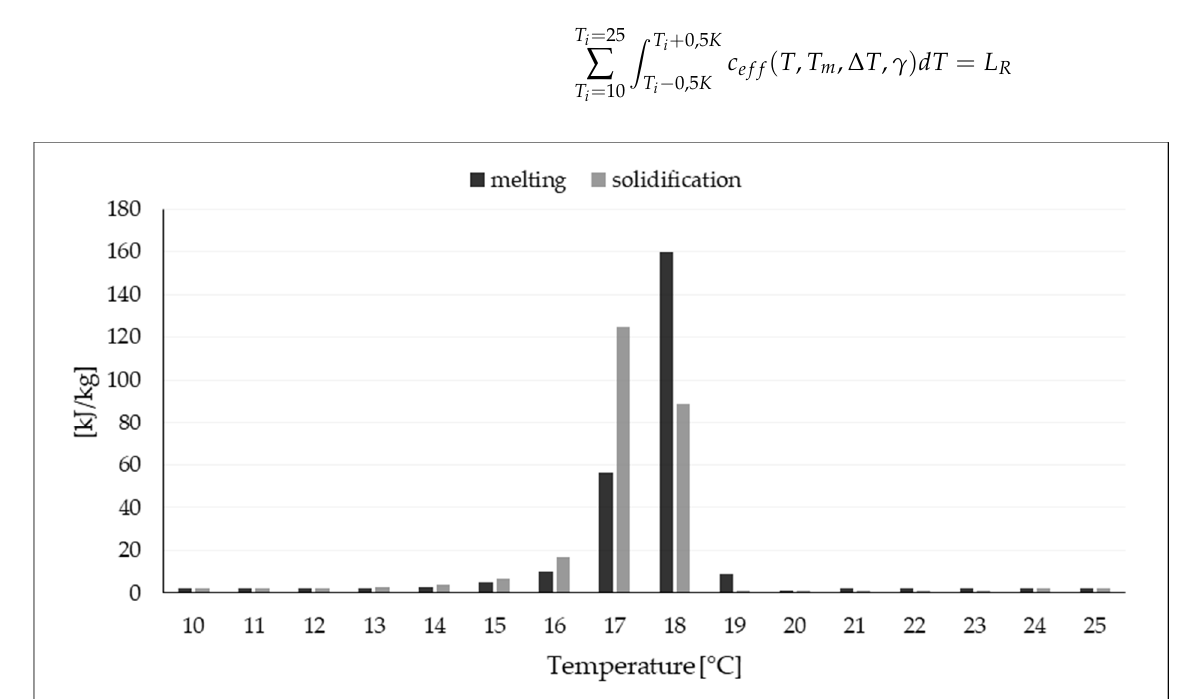
Figure 6. Partial enthalpy distribution of RT18HC (rubitherm.eu (accessed on 20 May 2021)).